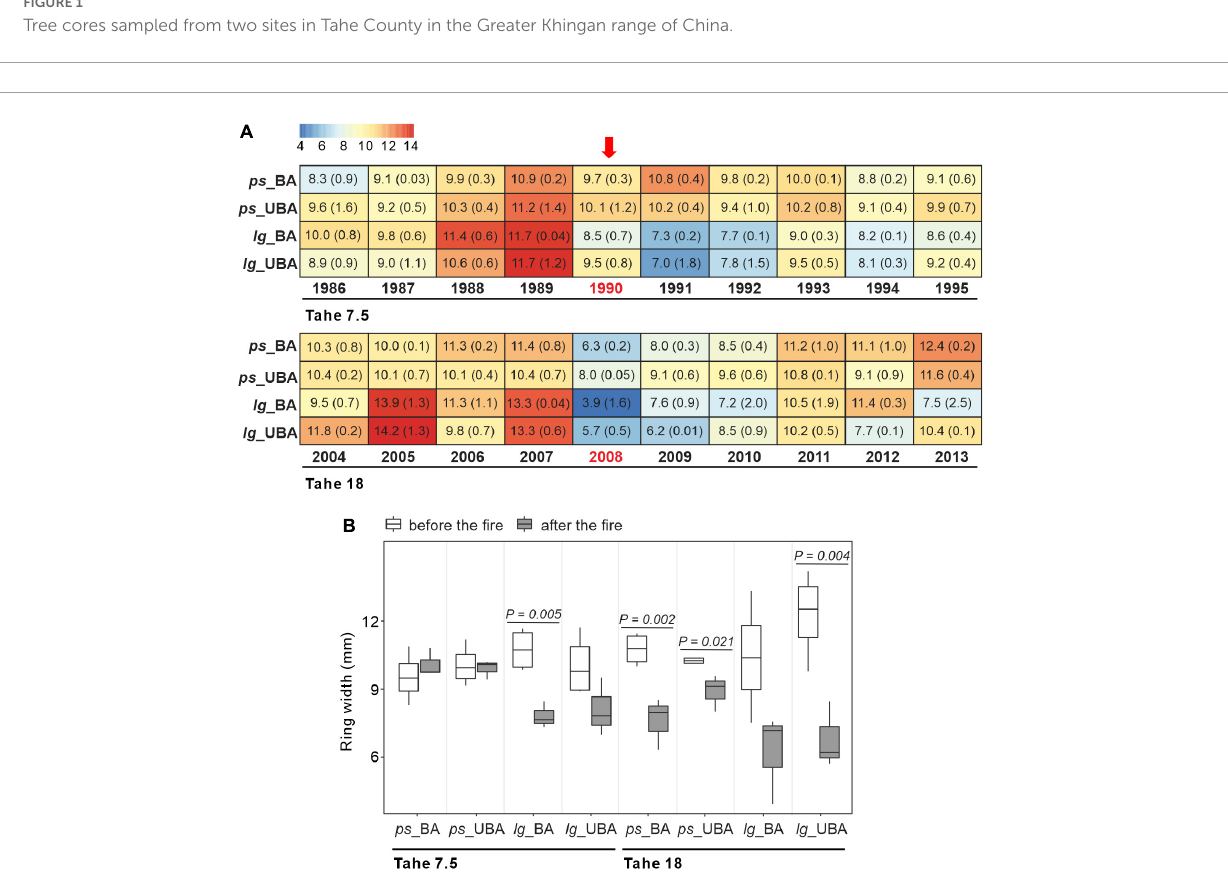
FIGURE2 Radial growth of tree rings. (A) Heatmaps of ring width [mean (standard errors)] in Tahe 7.5 (1986–1995) and Tahe 18 (2004–2013) in the burned area (BA) and unburned area (UBA), where ps and lg stands for Pinus sylvestris and Larix gmelinii , respectively. (B) Boxplots of ring width